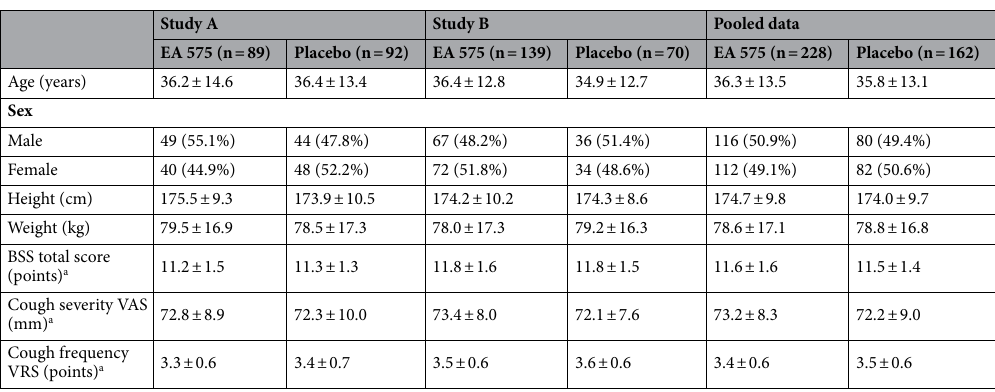
Table 1. Patient baseline characteristics (full analysis set; means ± SD or absolute frequency and %). BSS Bronchitis Severity Score, VAS Visual analog scale, VRS Verbal rating scale. a Higher scores indicate more pronounced